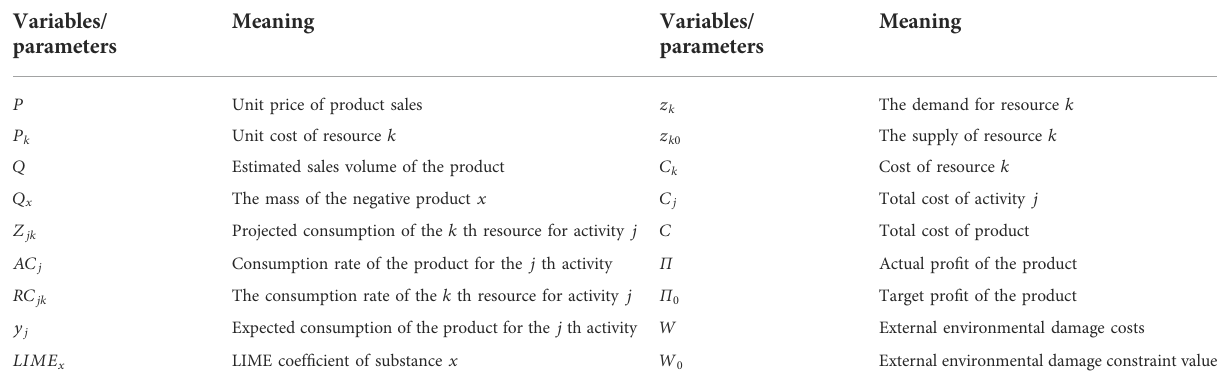
TABLE 1 Variables/parameters and their